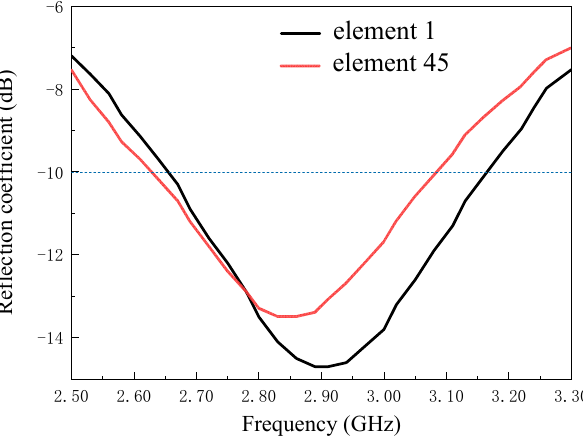
Figure 5. The S parameter of the 10 × 10 dipole planar array.